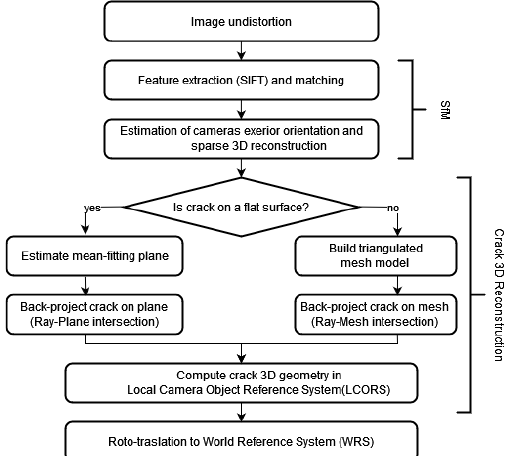
Figure 4 . Flow chart of SfM and crack reconstruction process.